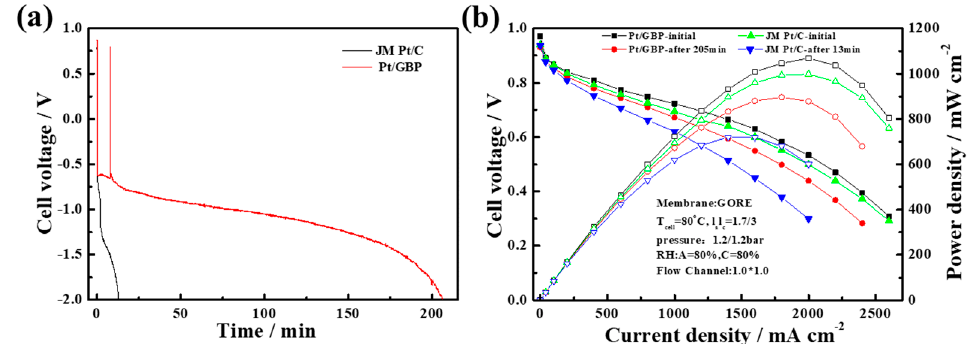
Figure 7. ( a ) Voltage reversal tests of MEAs fabricated with Pt/C and Pt/GBP and ( b ) polarization curves of MEAs before and after reversal tolerance test.